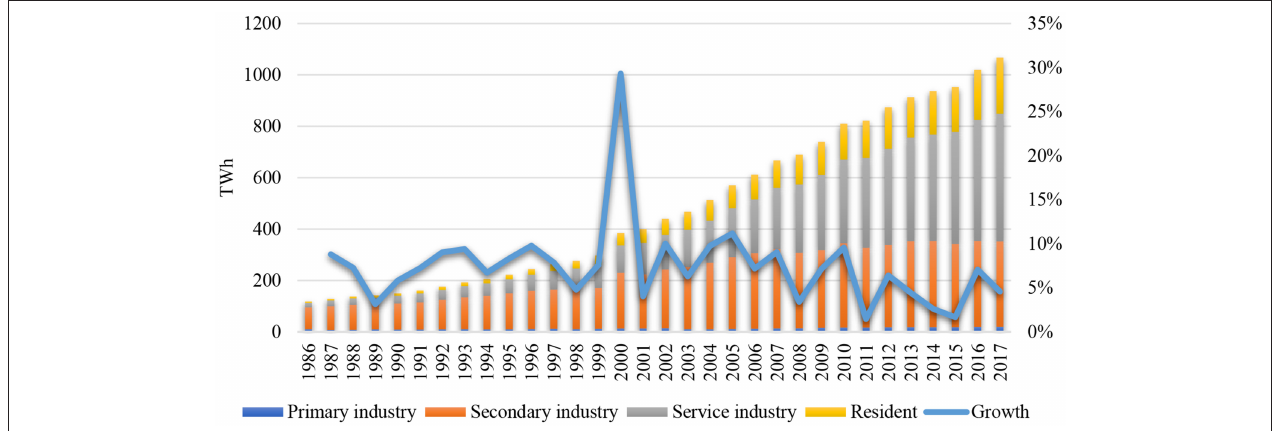
FIGURE 1 | Electric power consumption and annual growth of total power consumption in Beijing, 1986–2017. Primary industry refers to agriculture, forestry, animal husbandry, and fishery and services in support of these industries. Secondary industry refers to mining and quarrying, manufacturing, production, and supply of electricity, water and gas, and construction. The tertiary industry, namely service industry, refers to other industries except the primary industry and the secondary industry. Resident refers to the household. The annual growth is calculated compared to the previous year.